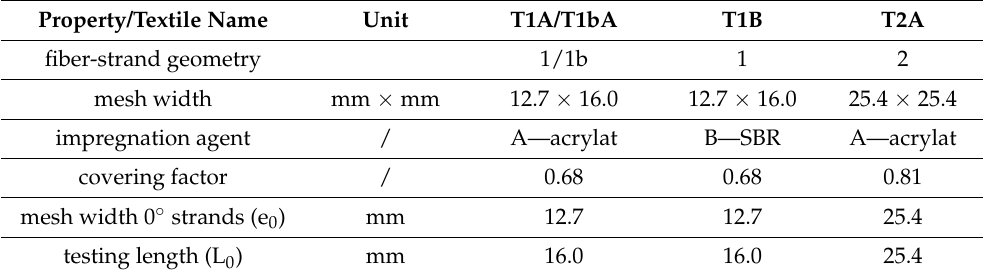
Table 1. Properties of the used textiles.